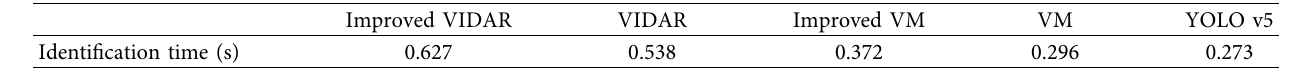
Table 6: Evaluation indices of detections of YOLO v5s and proposed